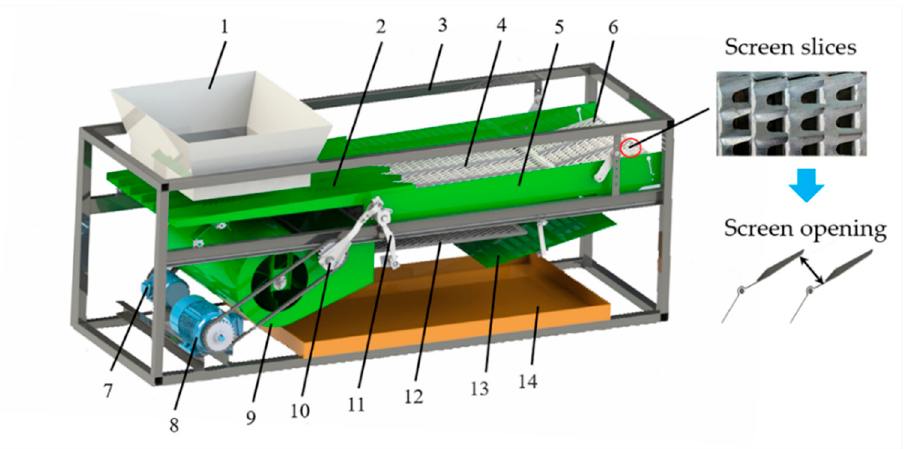
Figure 1. Air-screen cleaning system: 1. feeding hopper, 2. oscillating plate, 3. frame, 4. upper screen, 5. upper screen box, 6. tailing screen, 7. fan drive motor, 8. crank drive motor, 9. fan, 10. crank, 11. swing, 12. lower screen, 13. lower screen box, and 14. collection hopper.